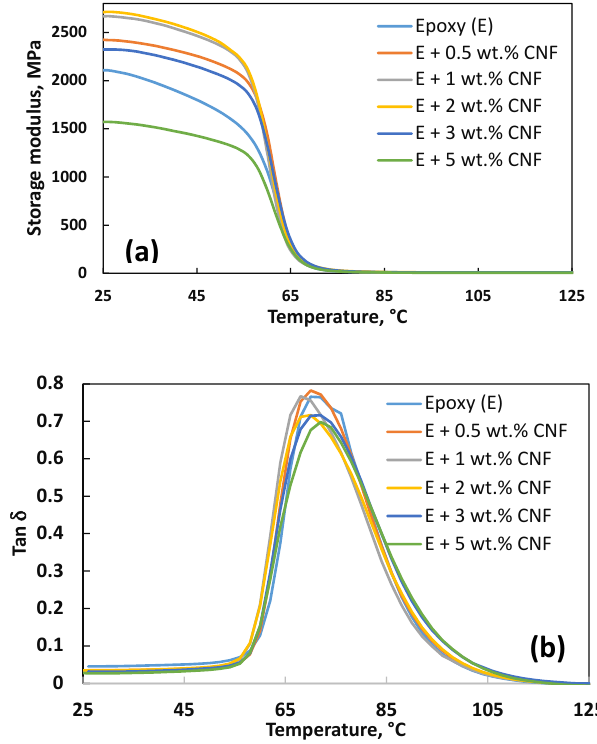
Figure 7. Dynamic mechanical analysis (DMA) of ( a ) storage modulus; ( b ) Tan δ of unfilled and CNF-filled nanocomposite series.